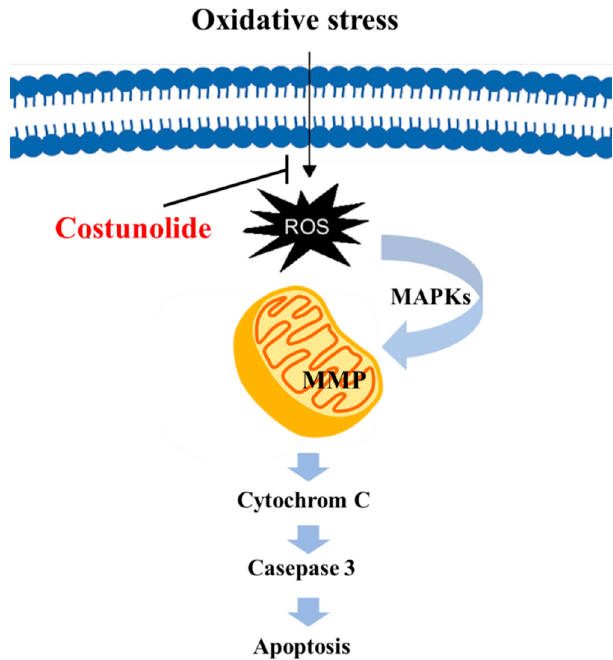
Figure 3. The effect of costunolide on apoptosis of neurons. Costunolide reduced intracellular ROS caused by oxidative stress. As a result, mitochondrial membrane potential (MMP) stabilized and apoptosis-related proteins such as caspase 3 decreased.